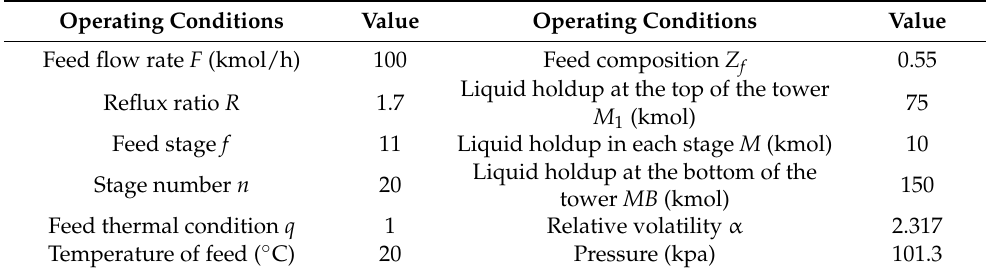
Table 3. Operating conditions of the distillation column in Case 2.